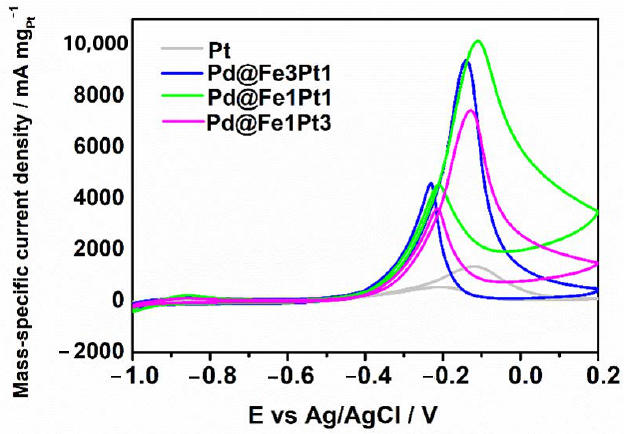
Figure 4. Cyclic voltammetry (CV) curves of Pd@FePt catalysts in 1 M CH 3 OH + 1 M KOH electrolyte. The scan rate was 50 mV s- 1 , and the current density was based on the loading amount of Pt.